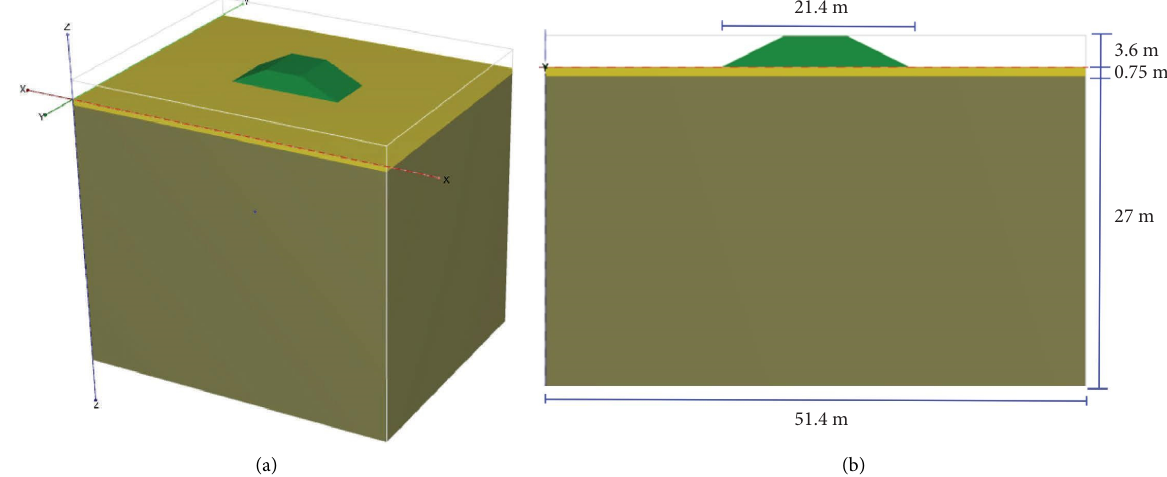
Figure 3: (a) 3D view of geometry of the model and (b) cross-section of the embankment and material